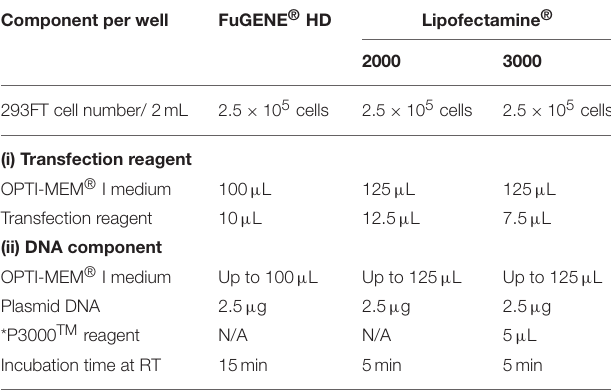
TABLE 1 | Lipid-mediated transient transfection experimental parameters and conditions. Component per